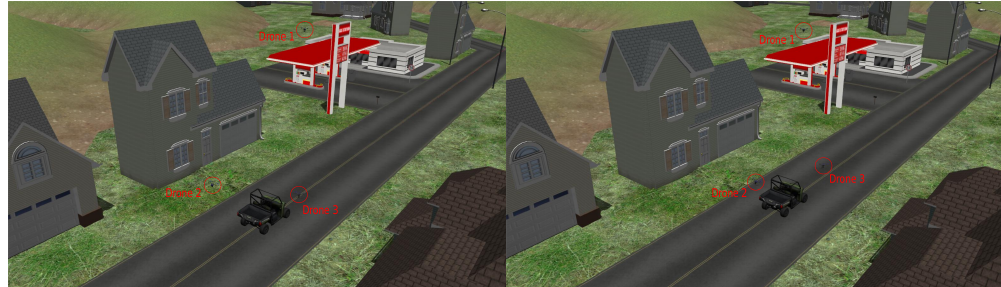
Figure 11. Screenshots of drones executing SA1 and SA3 in our simulation.